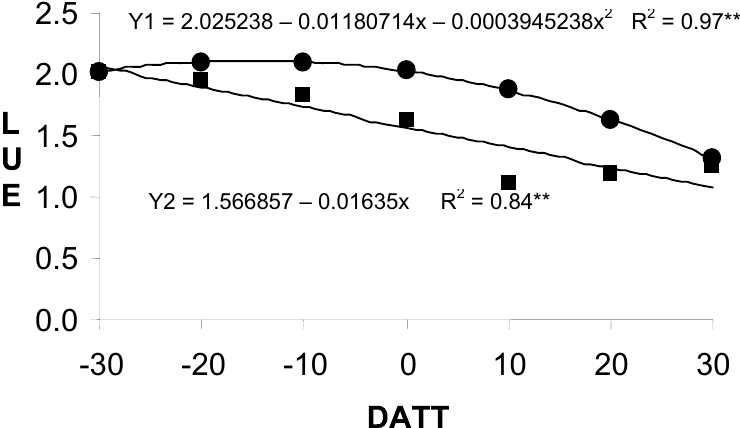
Fig. 1 – Land use efficiency (LUE) as a function of the number of days between the transplanting of lettuce in relation to tomato (days after transplanting of tomato, DATT), in the first (Y1) and second (Y2) cropping